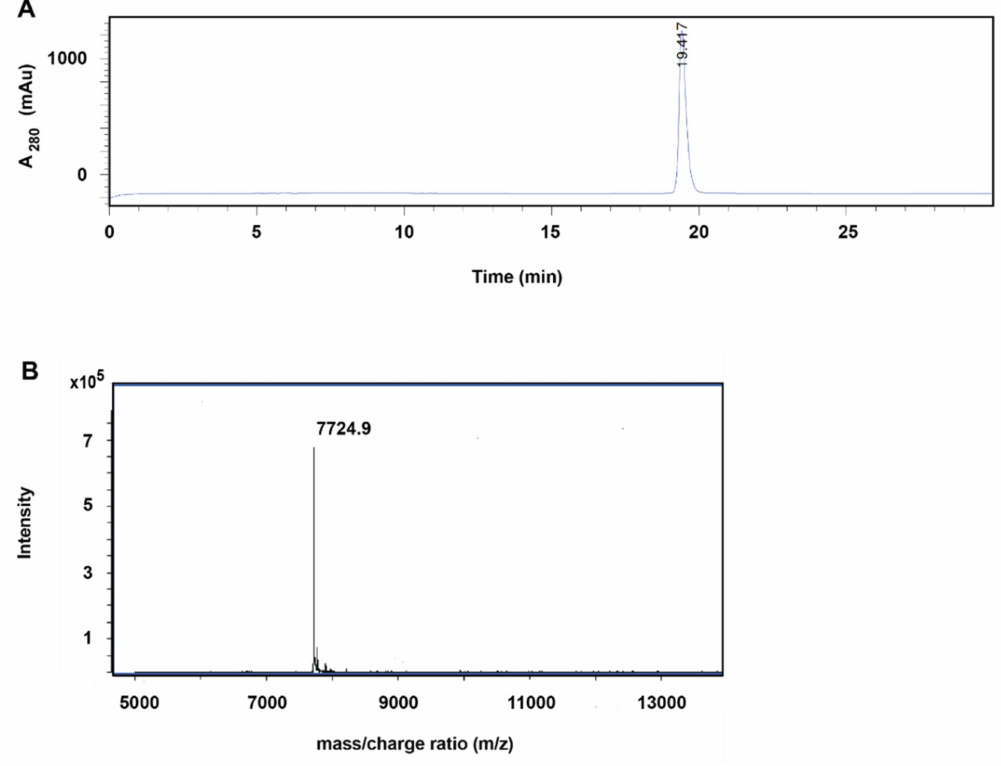
Figure 2. Analysis of NODAGA-(HE) 3 -Z IGF-1R:4551 by RP-HPLC ( A ) and mass spectrometry ( B ). The observed molecular weight was 7724.9 Da, and the calculated molecular weight was 7724 Da.